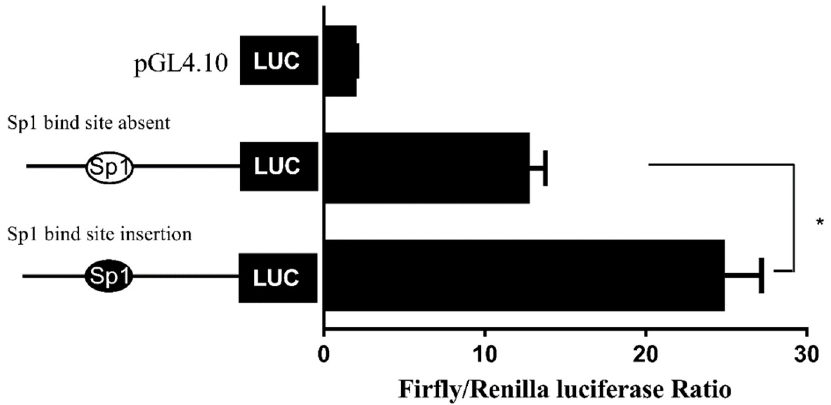
Figure 8. Effect of Sp1 binding site insertion on the activity of Δ 4 fad s 2 promoter. The Sp1 binding site of Δ 6/ Δ 5 fads2 , which was inserted into the corresponding area of Δ 4 fads2 is indicated with a black ellipse. Results are means ± SEM ( n = 6), * means significant difference ( p < 0.05).